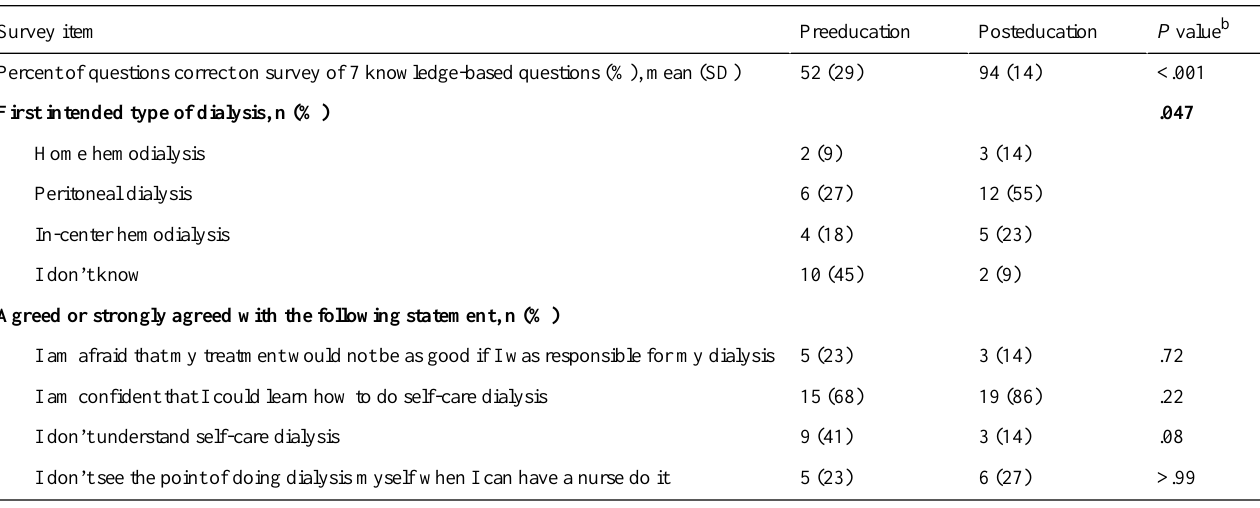
Table 2. Intervention group knowledge, confidence, and modality choice before and after the care program (n=22). a